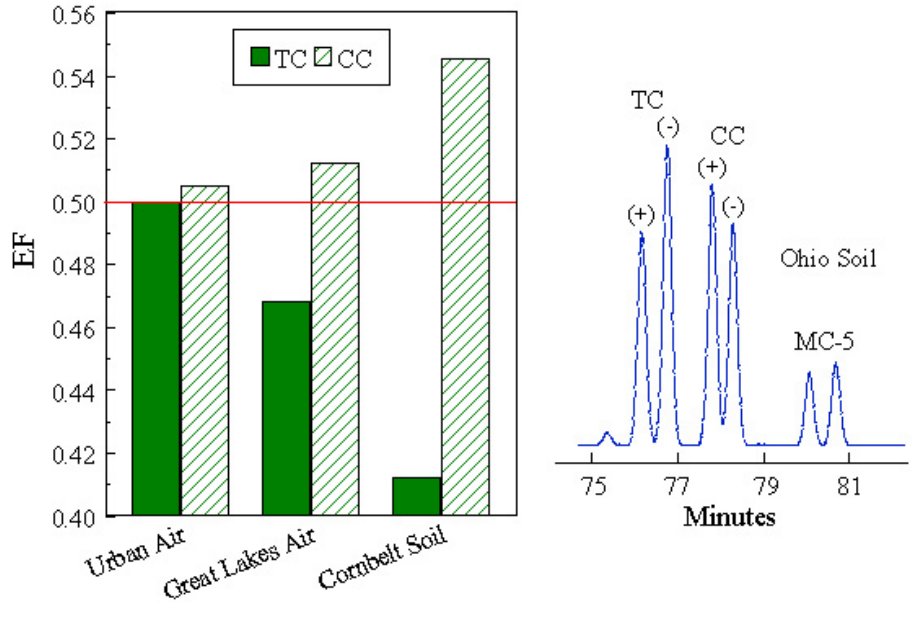
FIGURE 3. Right: chromatographic separation of enantiomers of TC, CC, and another chlordane (MC5) in an Ohio soil sample. Left: EF values for urban air (Columbia, SC), Great Lakes air, and average soil from the Midwestern U.S. cornbelt. Reproduced (modified) from Bidleman et al.[67].